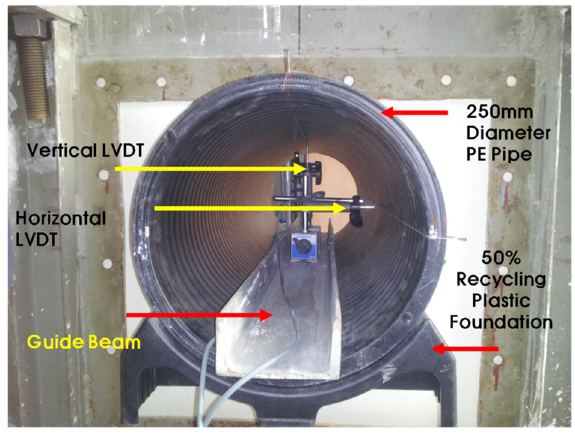
Figure 8. Loading system.